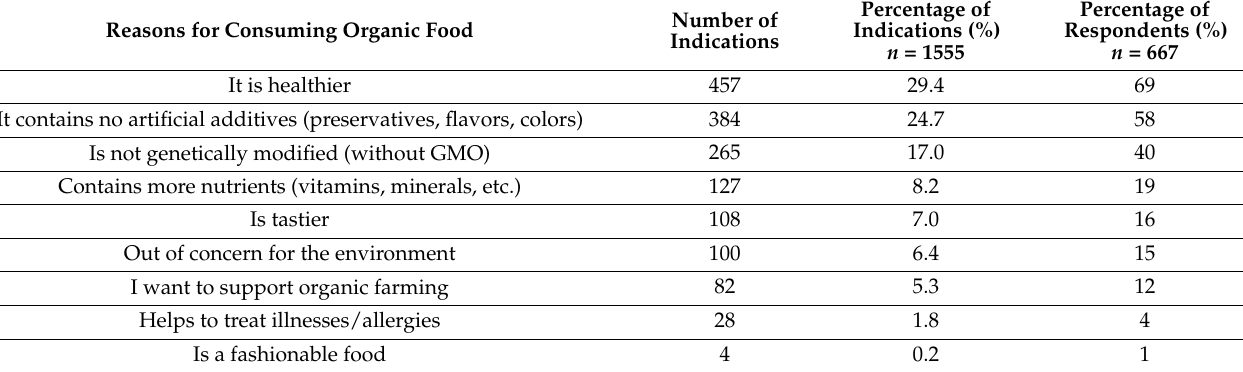
Table 9. Reasons for using organic food by respondents (multiple choice possible).